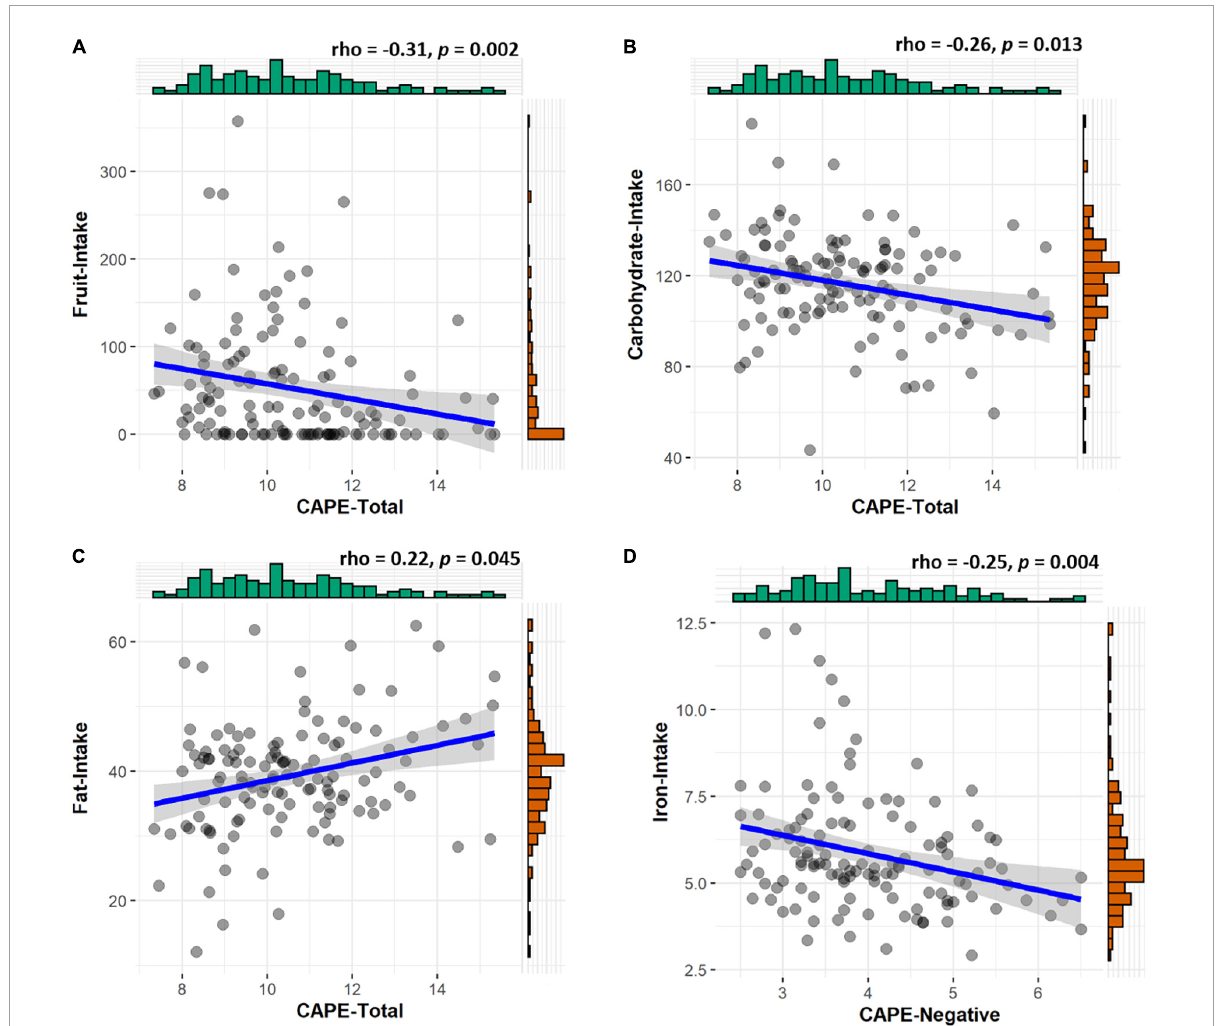
FIGURE3 Associations between psychotic-like experiences (PLEs) and food intake. PLEs negatively correlate with (A) fruit (rho = − 0.31, p = 0.002), (B) carbohydrate (rho = − 0.26, p = 0.013), and (D) iron (rho = − 0.25, p = 0.004) intakes. They also positively correlate with (C) fat intake (rho = 0.22, p =